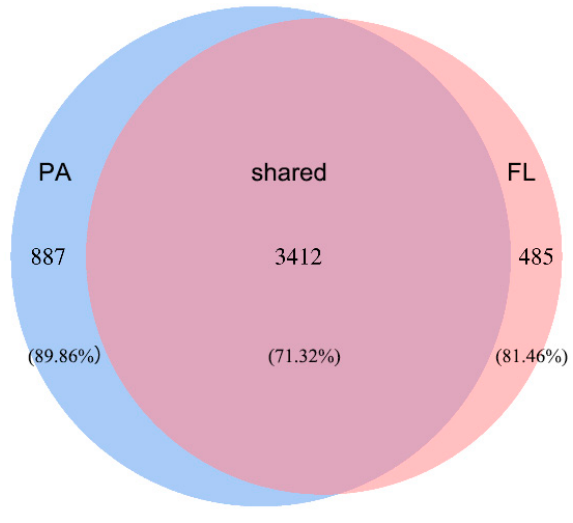
Figure 3. Venn diagram of bacterial community composition. PA: particle-attached bacteria. FL: free-living bacteria.